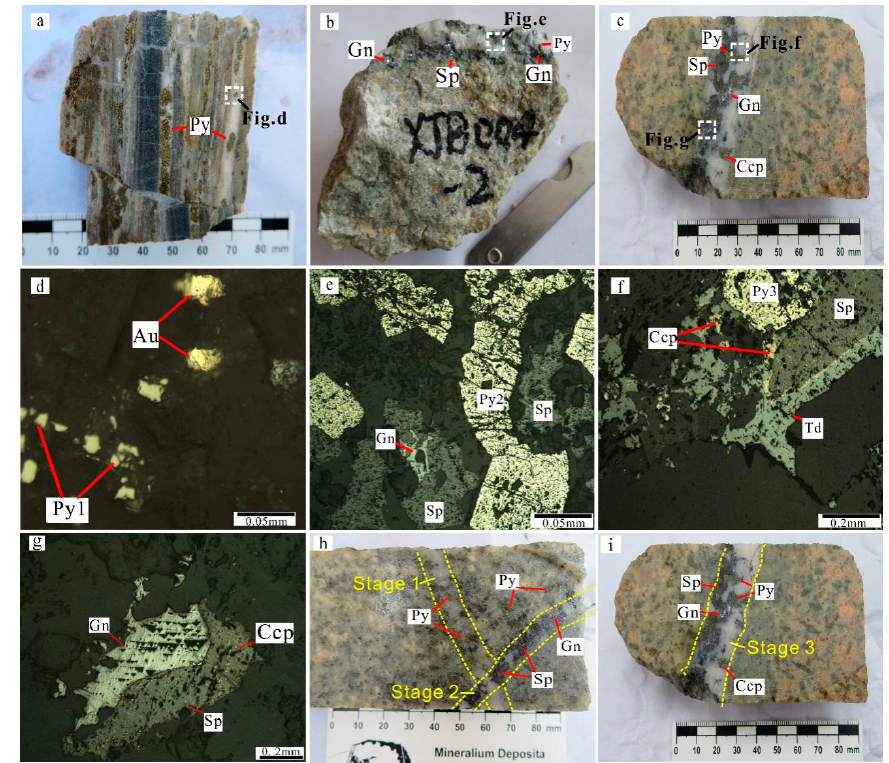
Figure 4. Mineral assemblages of the Xiajinbao deposit. ( a ) Banded auriferous pyrite–quartz vein type ores; ( b ) Galena–sphalerite–quartz vein-bearing altered granitic porphyry; ( c ) Multi–sulfide (pyrite, chalcopyrite, tetrahedrite, galena, sphalerite)–quartz-bearing altered granitic porphyry; ( d ) Native–gold–pyrite-bearing quartz vein; ( e ) Sphalerite replacing hypidiomorphic–allotriomorphic pyrite and replaced by galena; ( f ) Sphalerite replacing hypidiomorphic–allotrimorphic pyrite, chalcopyrite replacing pyrite and sphalerite, tetrahedrite replacing sphalerite, and chalcopyrite; ( g ) Common crystallization texture between galena and sphalerite; ( h ) Galena–sphalerite–quartz vein cutting through pyrite–quartz vein; ( i ) Multi–sulfides (pyrite, chalcopyrite, tetrahedrite, galena, sphalerite)–quartz vein. Py—pyrite; Ccp—chalcopyrite; Gn—galena; Sp—sphalerite; Td—tetrahedrite; Bi—bismuth.